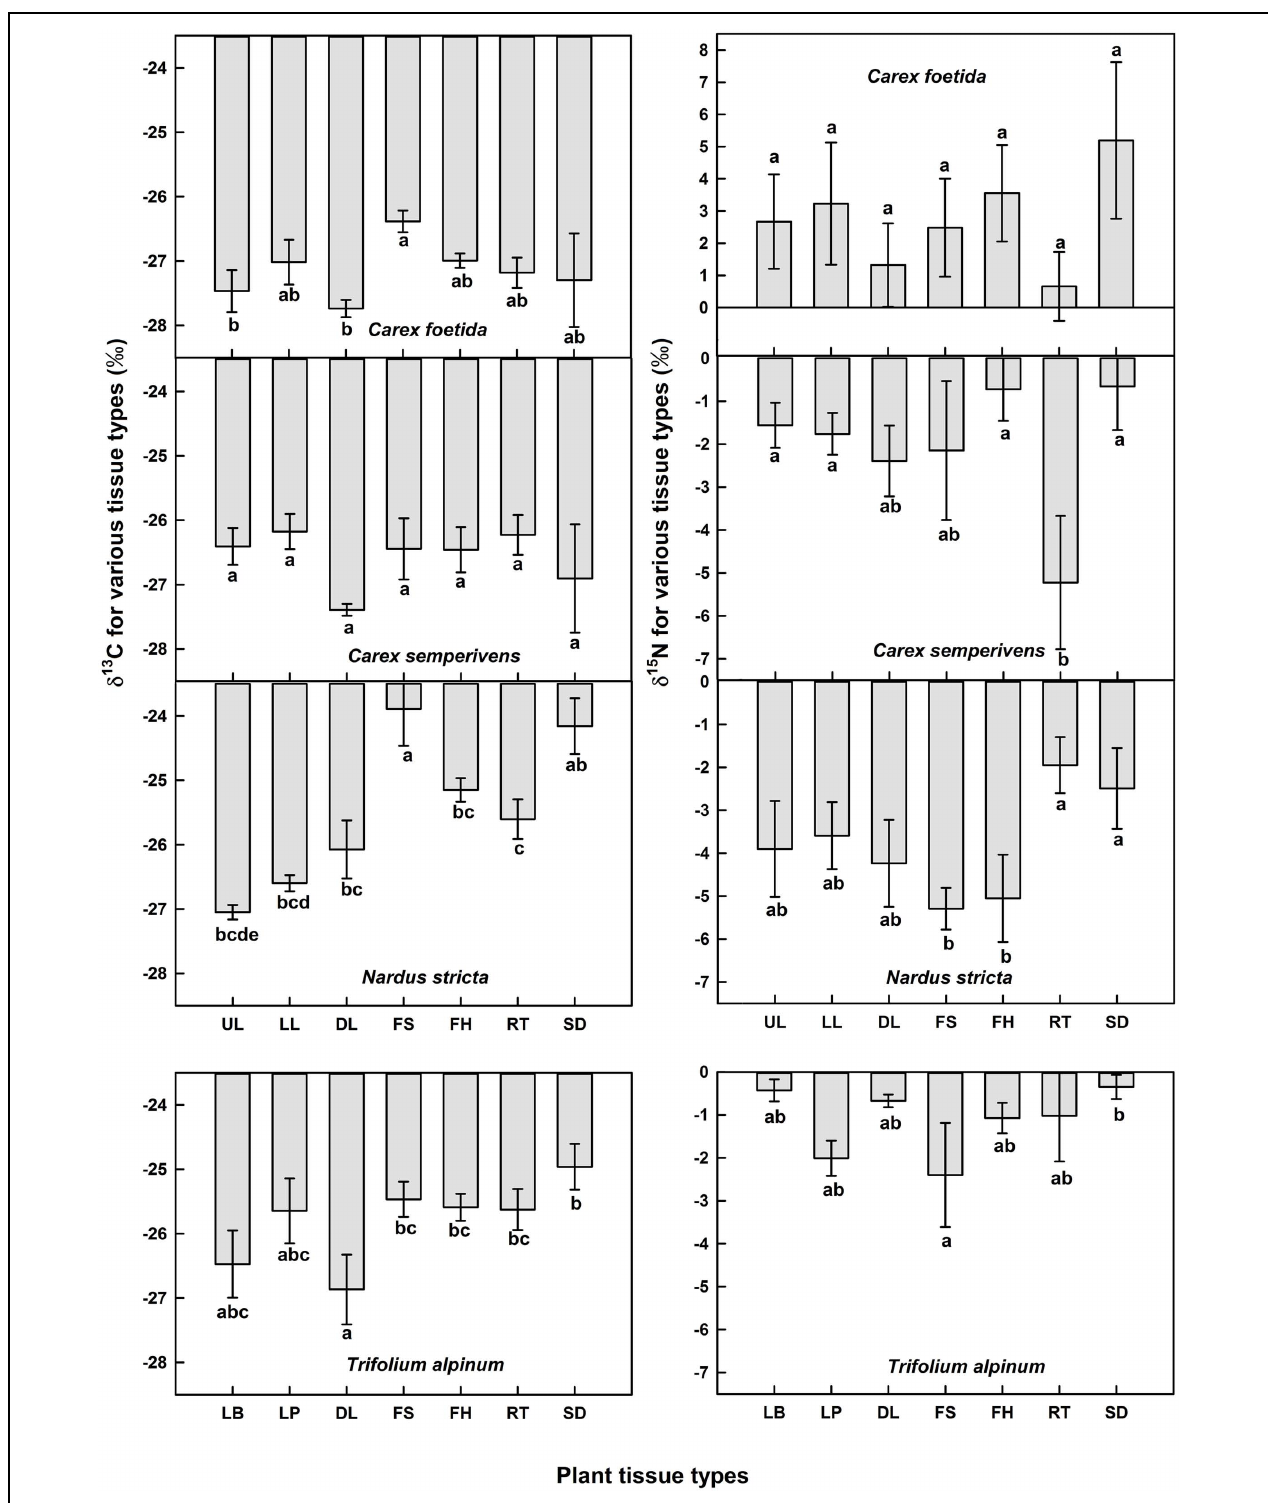
FIGURE 2 | Means of δ 13 C and δ 15 N signals in different organs in Carex foetida , C. semperivens , Nardus stricta, and Trifolium alpinum (mean ± SE, n = 3 individuals). UL, upper leaf parts; LL, lower leaf parts; DL,